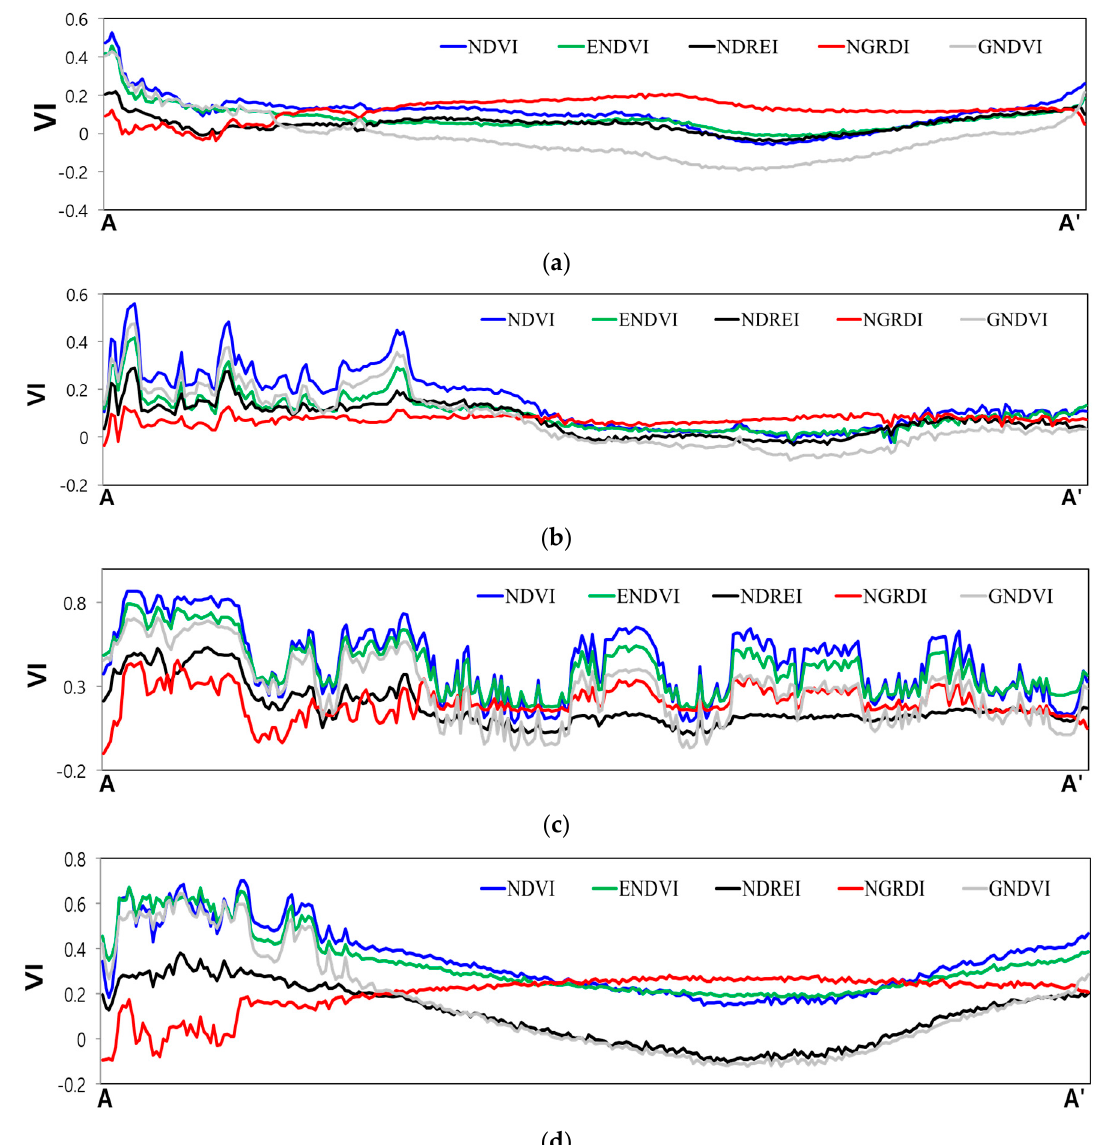
Figure 8. Profile analysis results of each vegetation index on each day. ( a ) 25 April 2018; ( b ) 20 May 2018; ( c ) 25 June 2018; ( d ) 24 October 2018.